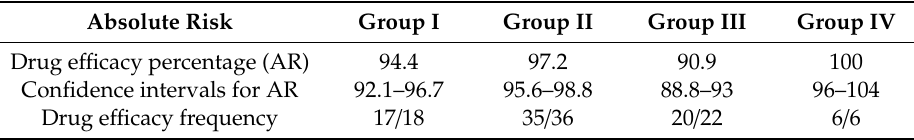
Table 4. Comparison of e ffi cacy of drug